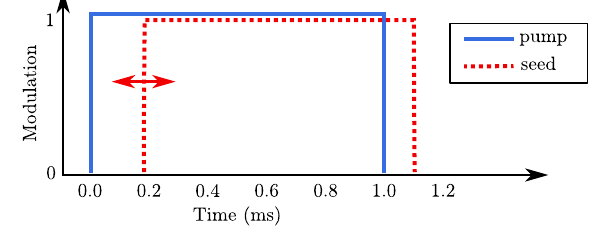
FIG. 3. Modulation envelopes of the seed and pump laser for burst operation with the pump preceding the seed for high gain.